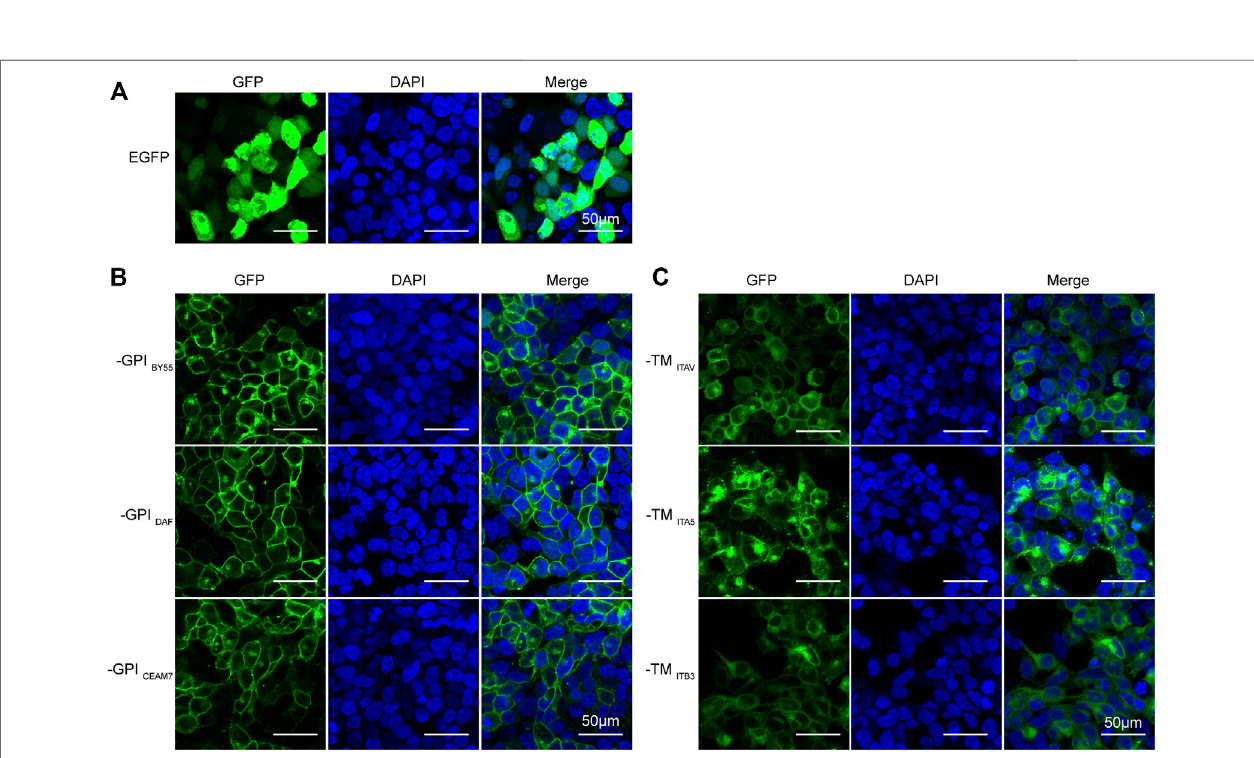
FIGURE 2 | Ef fi cient membrane-anchoring of six sorting tag variants. Laser scanning confocal microscopy of Lenti-X 293T cells transfected with the pEGFP-C2 plasmid (A) , three GPI-type TST-EGFP sorting tag expression plasmids (B) , and three TM-type TST-EGFP sorting tag expression plasmids (C) . DAPI stains cell nuclei. Cells were observed at ×200 magni fi cation, scale bar = 50 μ